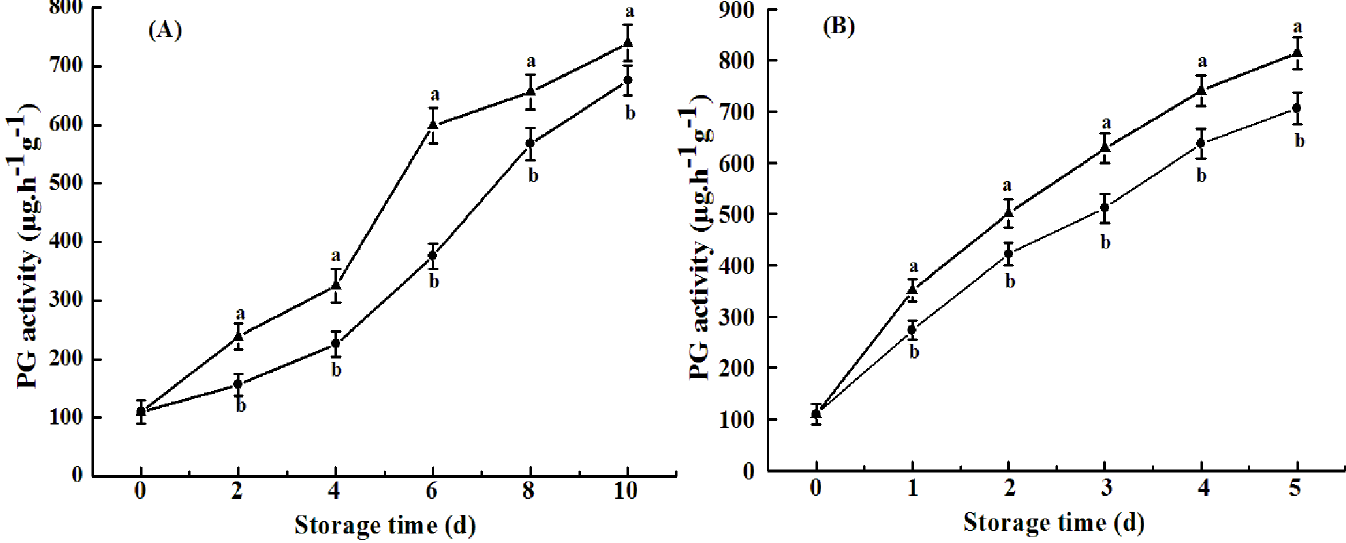
Fig 5. PG activity of avocado fruits upon natural (A) or ethylene-induced (B) ripening with ( ● ) or without ( ▲ ) cold shock treatment (CST) during 10- or 5-day storage at 20˚C and 85–90%RH. Vertical bars represent the standard error of three replicates.Different letters at any storage time indicate significantdifferences (P <